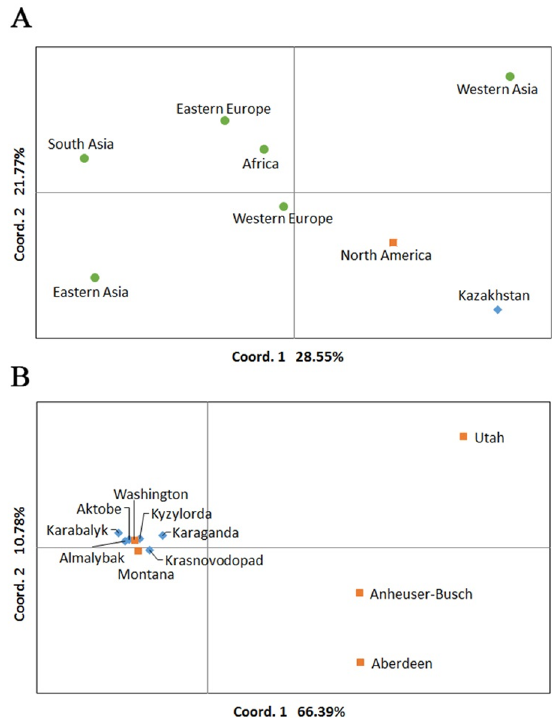
Fig 4. Principal coordinate analysis of barley accession SNP data. A. Clustering of barley accessions from eight regions of the World based on using the 9 K SNP Illumina genotyping assay. B. Clustering of accessions from five USA and six Kazakh breeding organizations based on 2321 polymorphic SNPs from the two Barley Oligo Pool Assay (BOPA1 and BOPA2) sets [14].